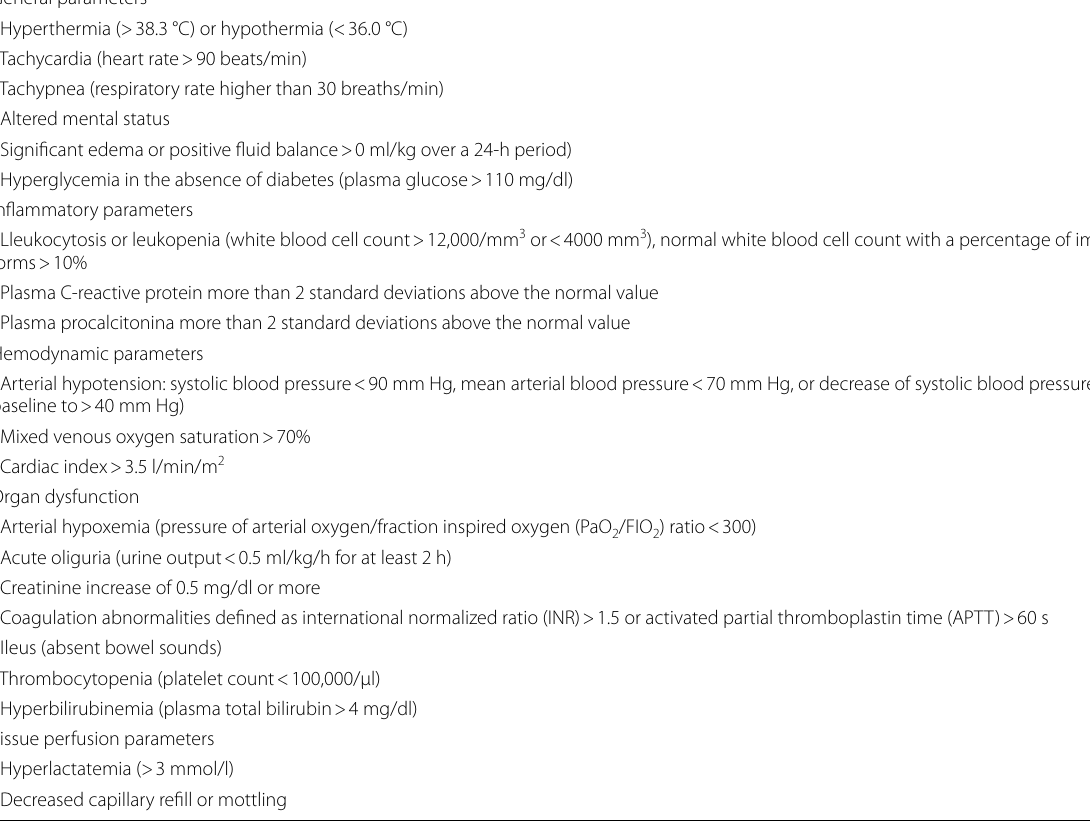
Table 1 Inclusion criteria for sepsis General